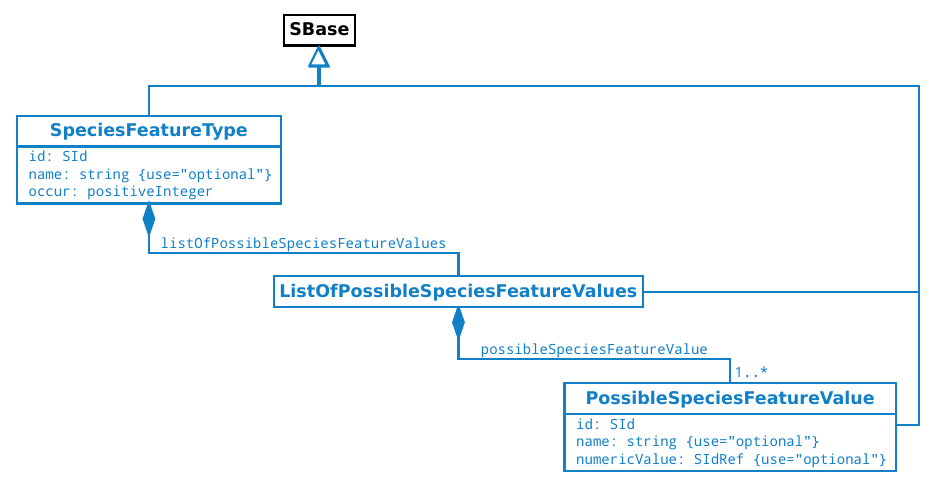
Figure 4: The definitions of SpeciesFeatureType , ListOfPossibleSpeciesFeatureValues and PossibleSpecies- FeatureValue classes. dren. Since ListOfPossibleSpeciesFeatureValues is derived from SBase through ListOf , it inherits the sboTerm and metaid attributes, as well as the optional child Notes and Annotation